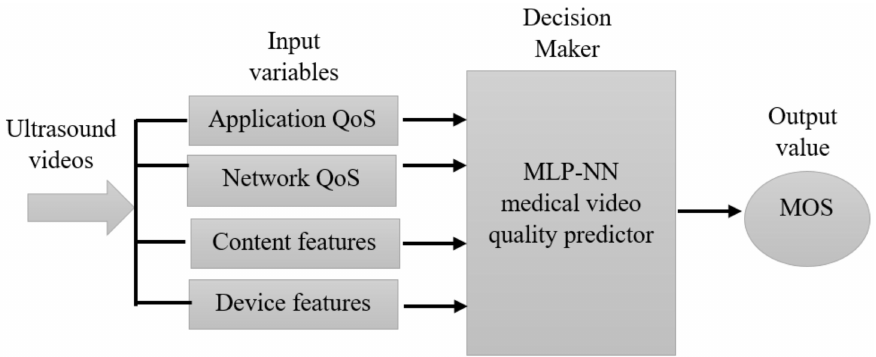
Figure 1. Functional block diagram of proposed m-QoE model.